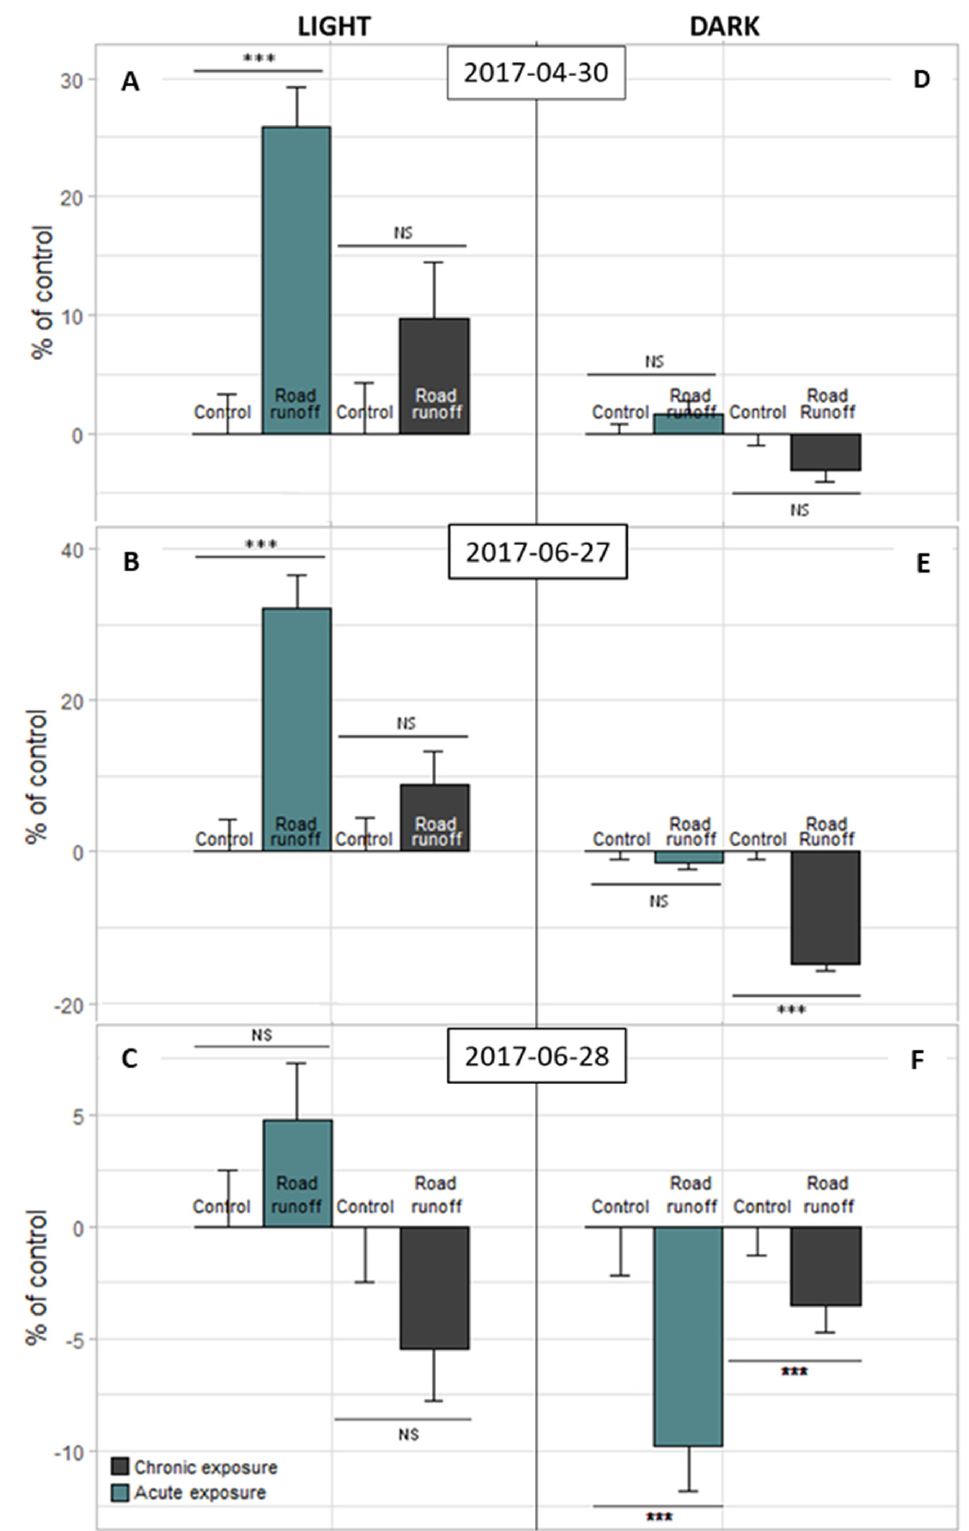
Figure 1. Activity (% of control) of 6 dpf old zebrafish larvae exposed to RR from C site in chronical and acute exposure ( A – C ): light condition; ( D – F ): dark condition. Control = E3 solution; number of larvae = 36 per condition; NS = not significant; * = p -value < 0.05; ** = p -value < 0.01; *** = p -value < 0.001 (non-parametric Kruskal–Wallis test). Error bars represent the standard error.